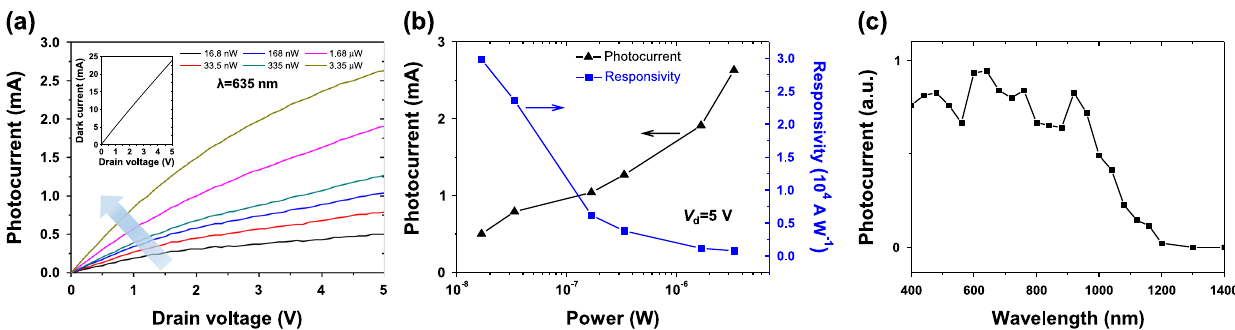
Fig. 2 Photoresponse of the hybrid graphene photoconductor. a Photocurrent vs. drain voltage under various light powers at 635 nm wavelength. The arrow indicates the direction of light power increase. The inset shows the dark current of the device. b Power-dependent photocurrent and photoresponsivity at 5 V drain voltage calculated from the data in ( a ). c Normalized photocurrent vs. illumination